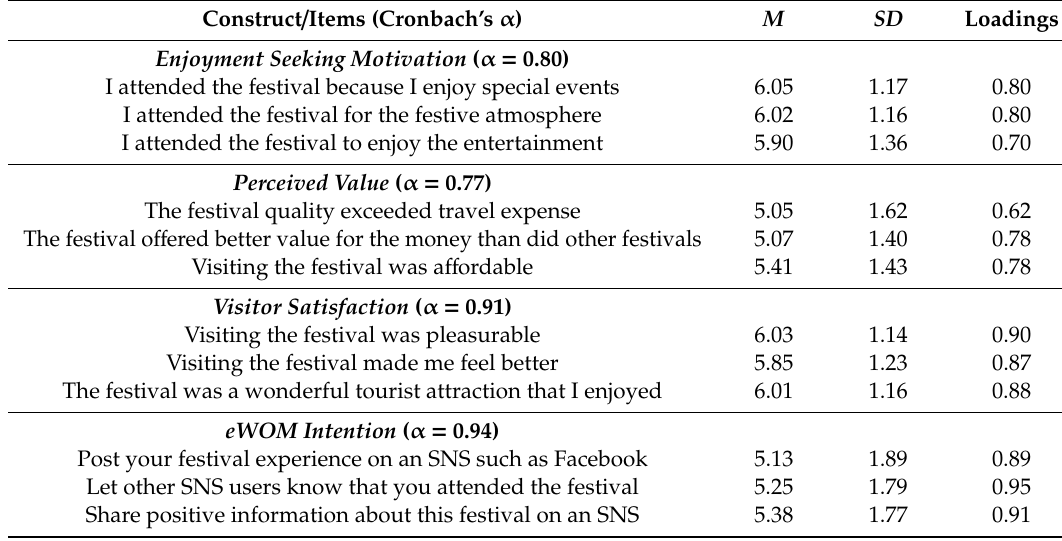
Table 3. Results of CFA.